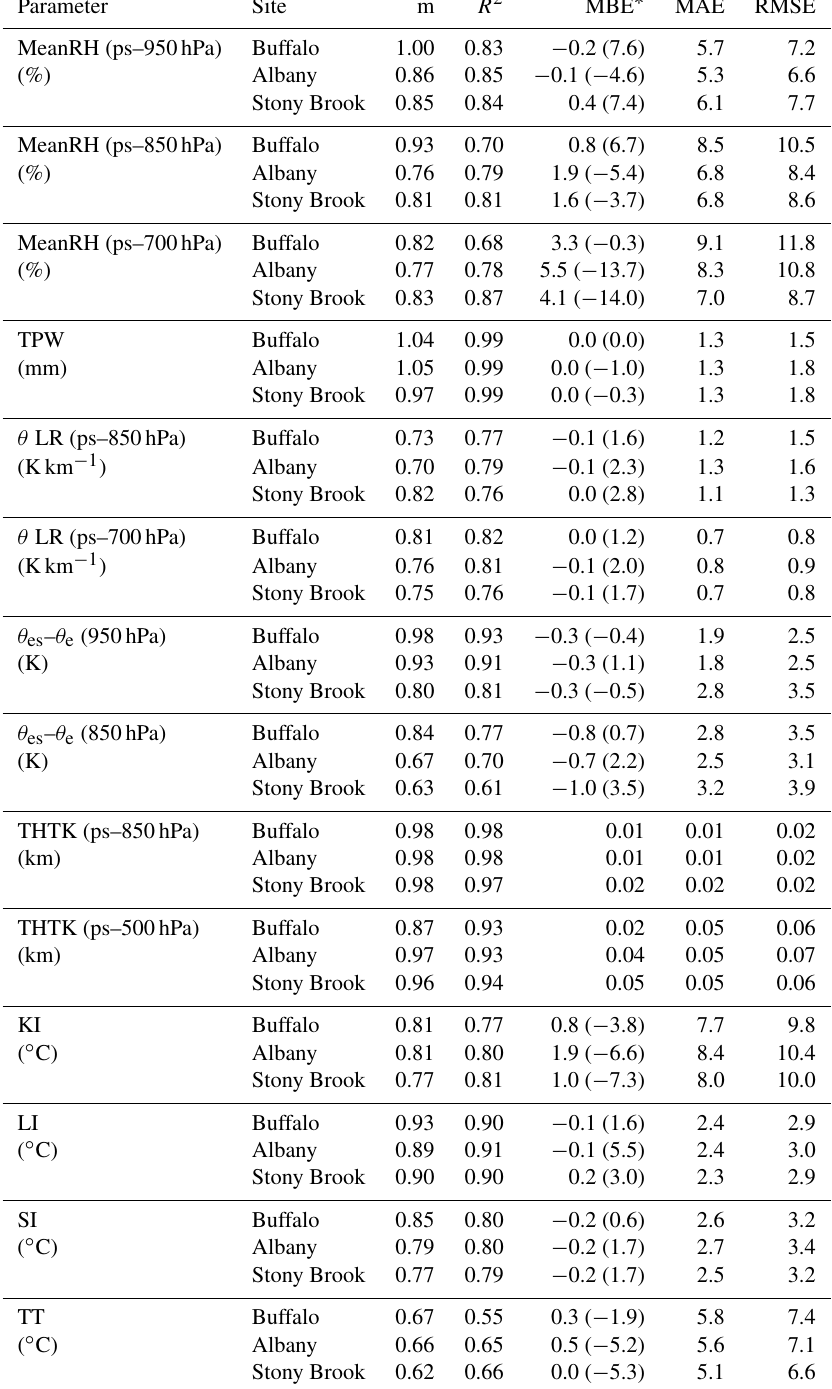
∗ MBE values in parentheses represent values from the original